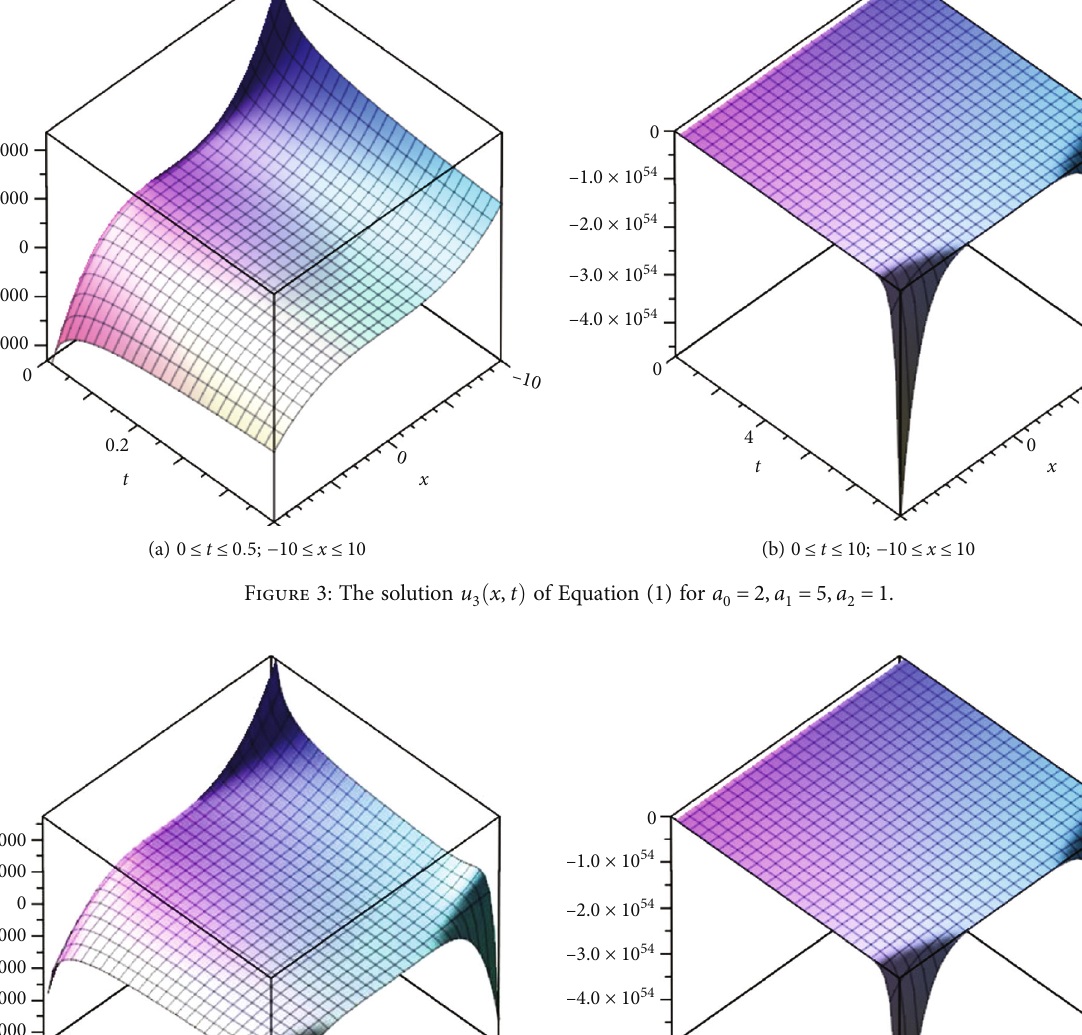
Figure 3: The solution u